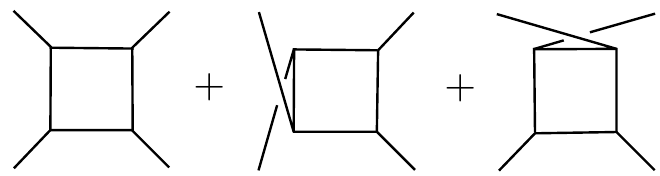
Figure 6 . The one-loop amplitude in ten-dimensional type IIB supergravity is the sum of three scalar box